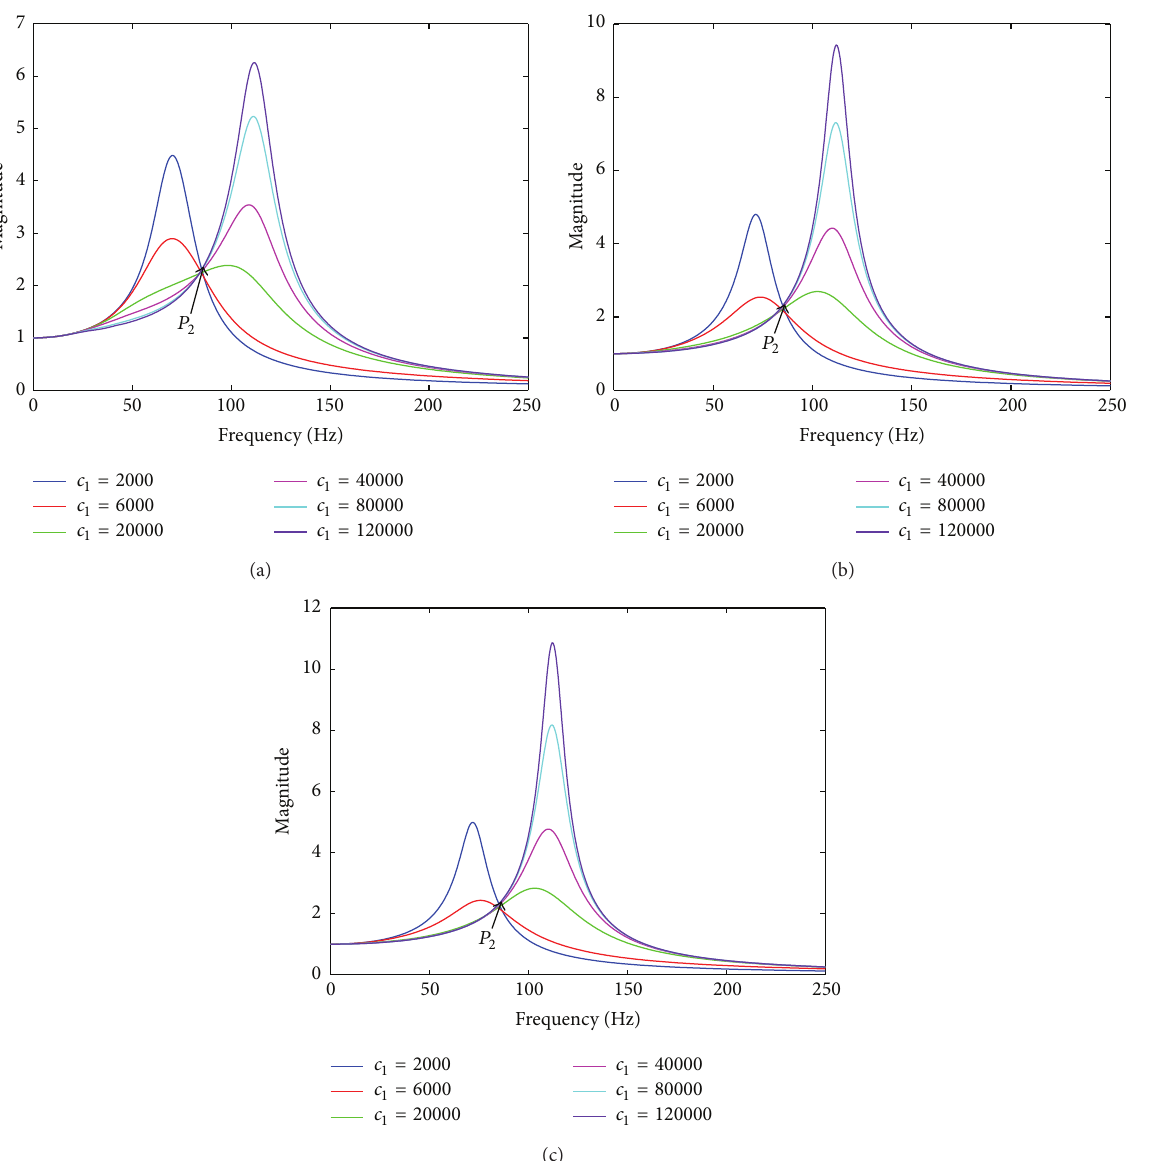
Figure 20: Absolute displacement transmissibility curves of CM under 0.76 mm FDE cases. (a) 𝑛 1 = 1.5 ; (b) 𝑛 1 = 1 ; (c) 𝑛 1 = 0.85